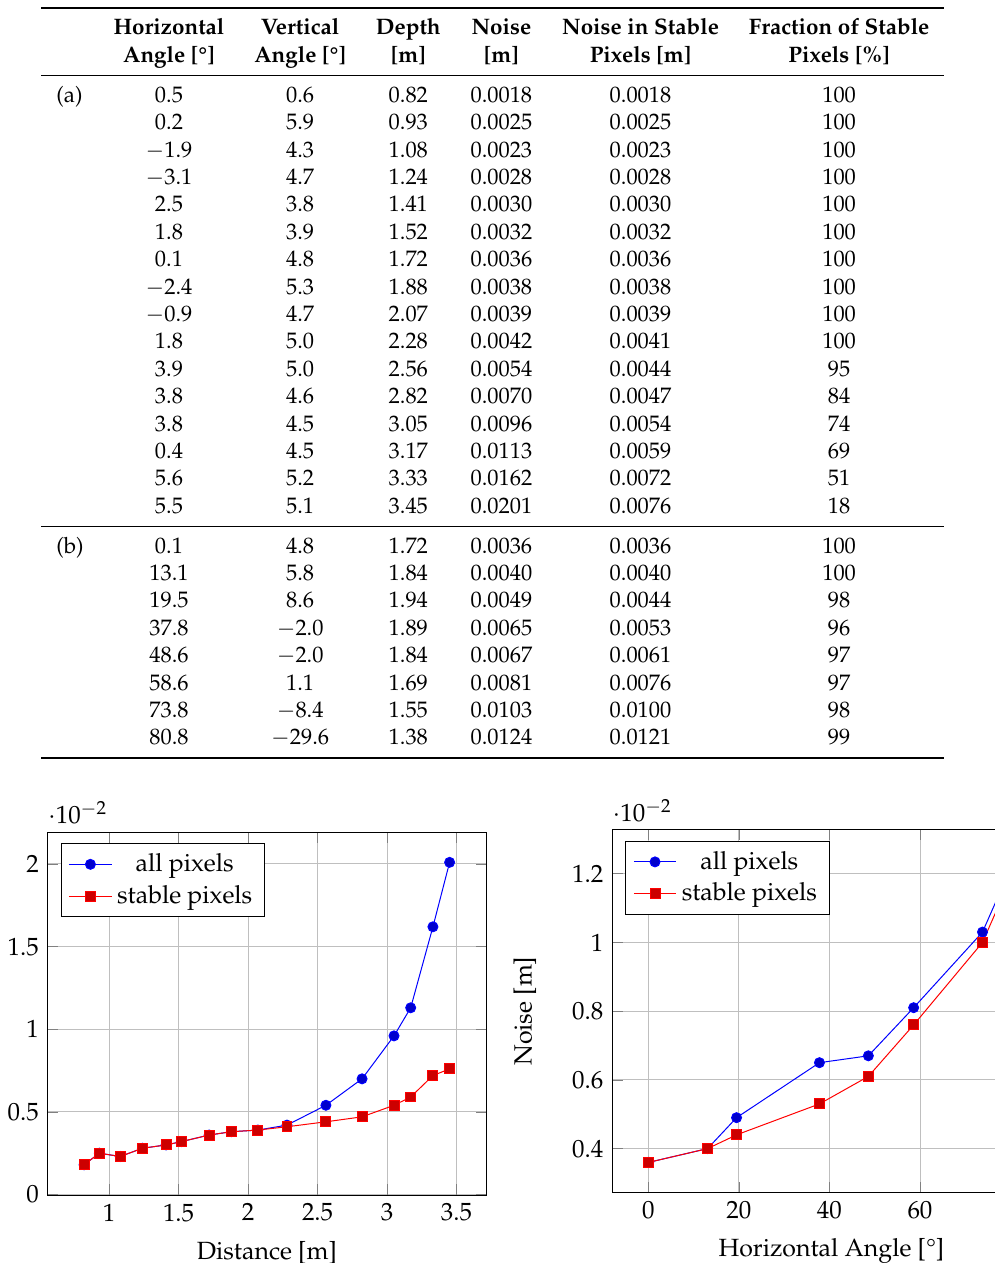
Table 2. Noise of the distance measurements of the HoloLens ToF sensor against distance and inclination of a captured plane. Stable pixels are pixels that have range measurements in at least 75% of images. Part (a): variation of distance; part (b): variation of inclination.